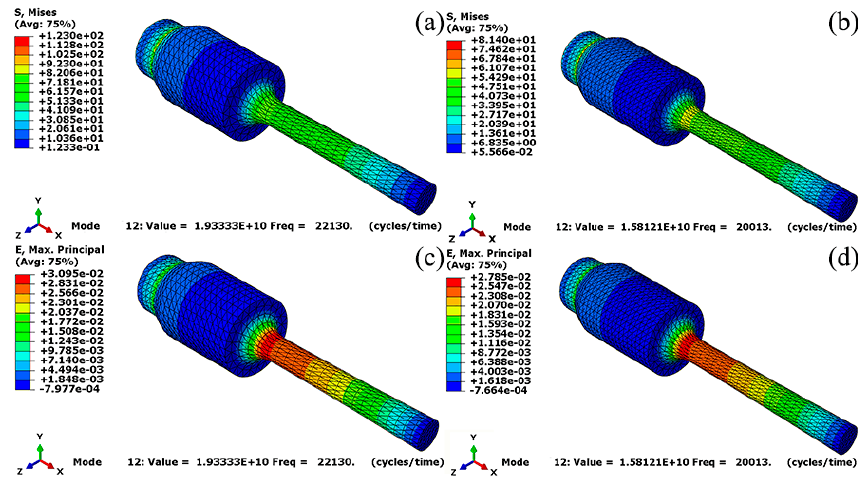
Figure 8. Cloud diagram of the maximum stress and strain in longitudinal vibration, ( a ) stress before optimization, ( b ) stress after optimization, ( c ) strain before optimization, ( d ) strain after optimization.